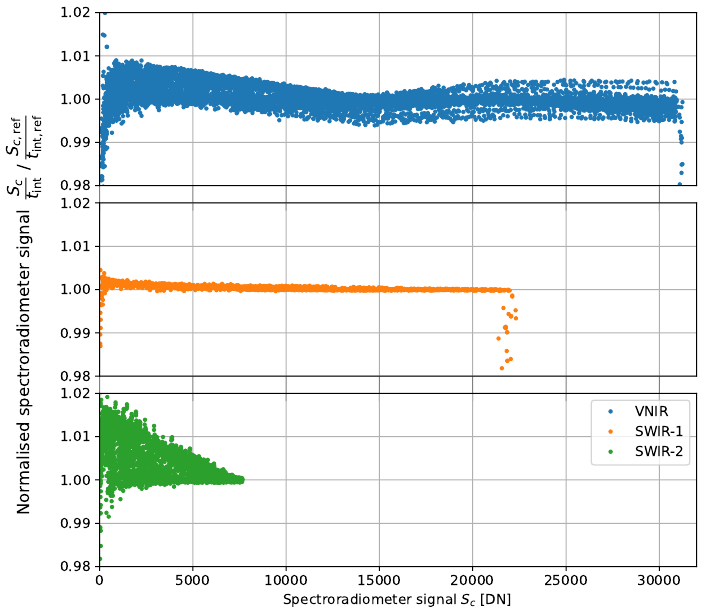
Figure 6. Spectroradiometer signals S c of each detector array scaled by its integration time t int and normalized to the reference signal S c ,ref at reference integration times t int,ref = 80ms, 40ms, and 15ms for the VNIR, SWIR-1, and SWIR-2 detectors,